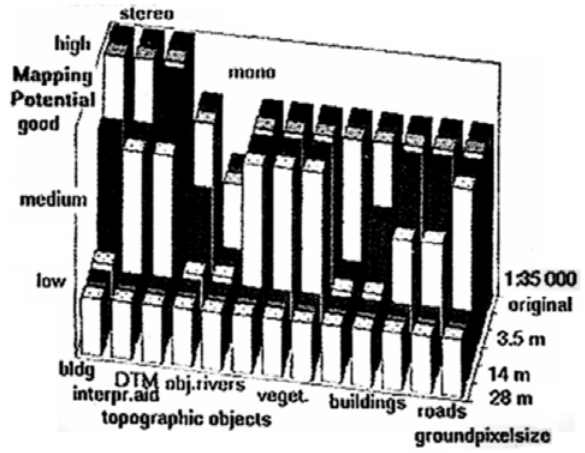
Figure 5. Comparison of the interpretation results of an original analog aerial 3D photography (scale 1:35 000) with the interpretation results obtained using the same stereo pair, but now digitized with 50, 100, 200, 400 and 800 µm pixel size, equivalent to 1.8m, 3.5m, 7m, 14 m and 28m ground pixel size (EXCEL evaluation by W. Schuhr, based on interpretations by A. Elmhorst under the aegis of G. Konecny).